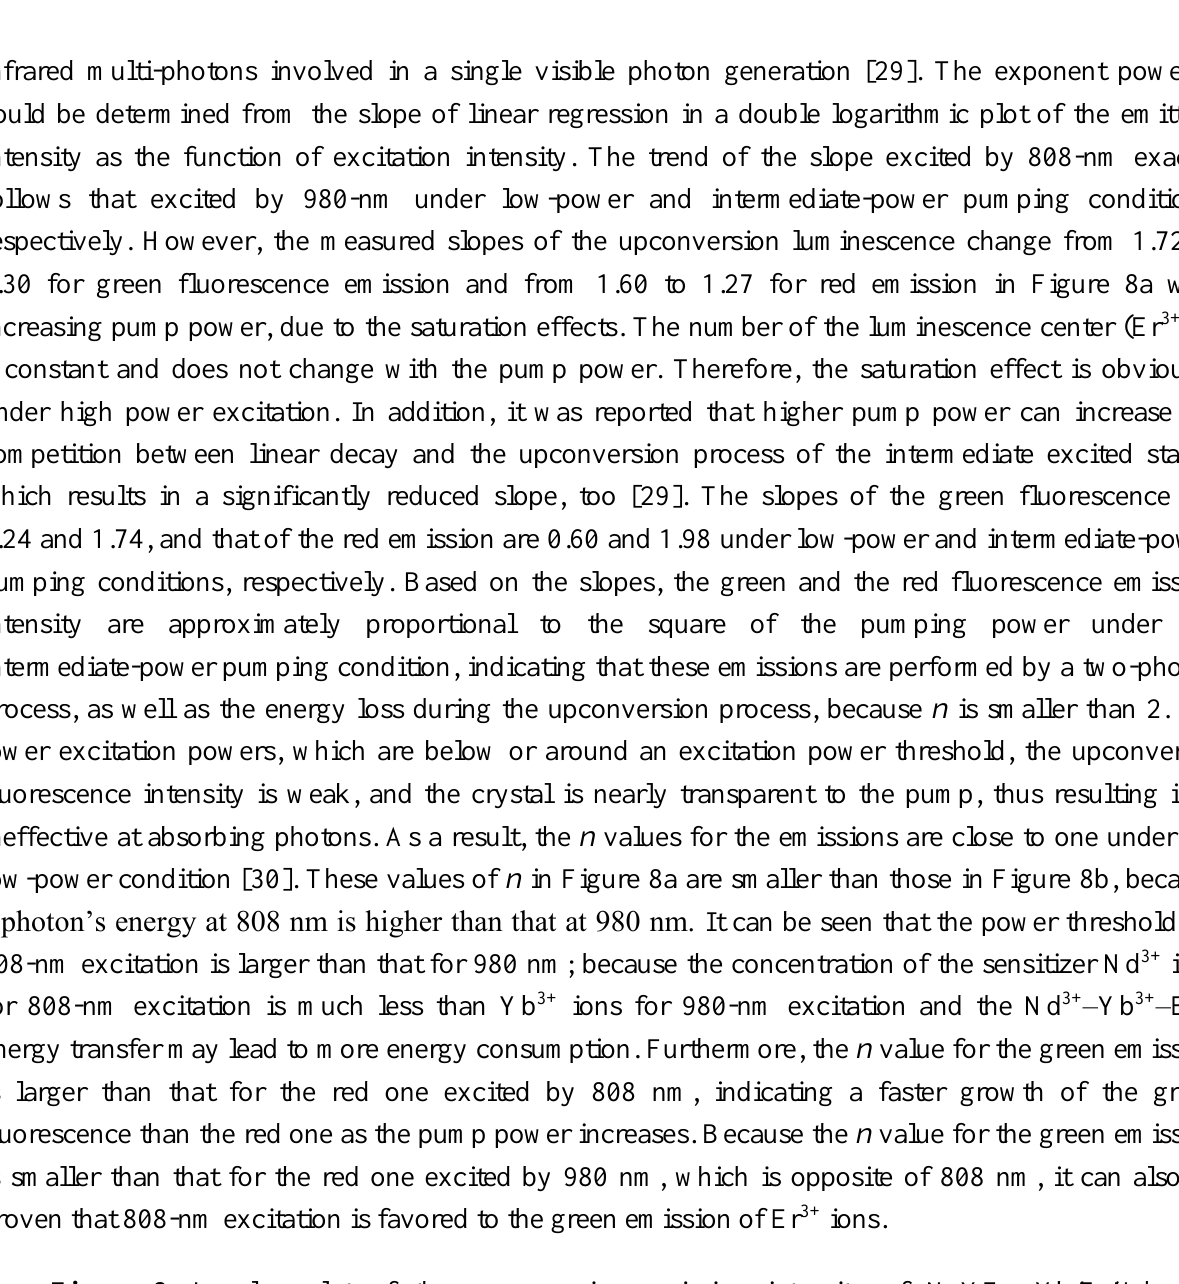
Figure 8. Log-log plot of the upconversion emission intensity of NaYF 4 : Yb/Er/Nd (20/2/0.5 mol%) nanoparticles as a function of the pump power under ( a ) 808-nm excitation and ( b ) 980-nm